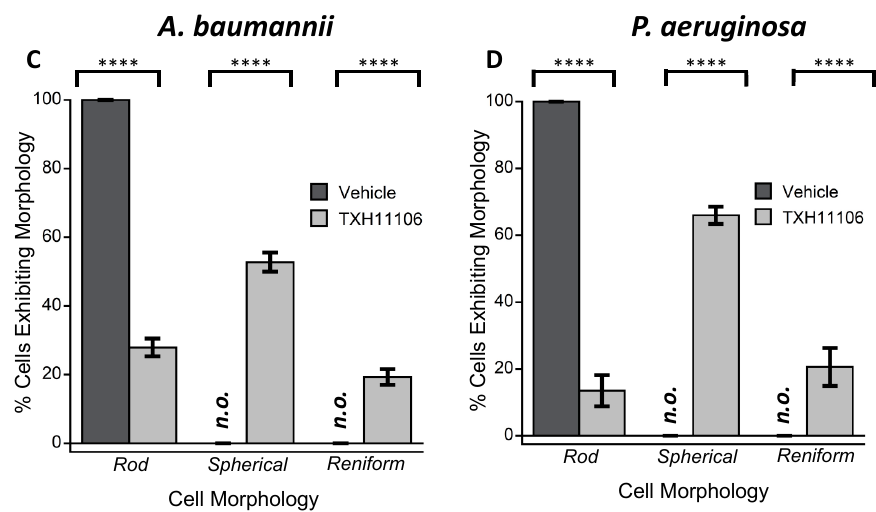
Figure 4. Quantification of the cell morphology results from the DIC microscopy experiments depicted in Figure 3. The bar graphs show the prevalence (in %) of the various cell morphologies (rod, spherical, and reniform) observed in the vehicle-treated groups ( n ranging from 349 to 1277) and TXH11106-treated groups ( n ranging from 550 to 1291) for E. coli 25922 ( A ), K. pneumoniae 13883 ( B ), A. baumannii 19606 ( C ), and P. aeruginosa 27853 ( D ). Each percentage reflects an average of 5 different fields of view, with the average number of cells in each field of view ranging from 70 to 255 in the vehicle-treated groups and 110 to 258 for TXH11106-treated groups. The indicated error bars reflect the standard deviation from the mean. The statistical significance of differences in cell morphology were analyzed using a one-way ANOVA test. **** reflects a p -value < 0.0001. n.o. = none observed.